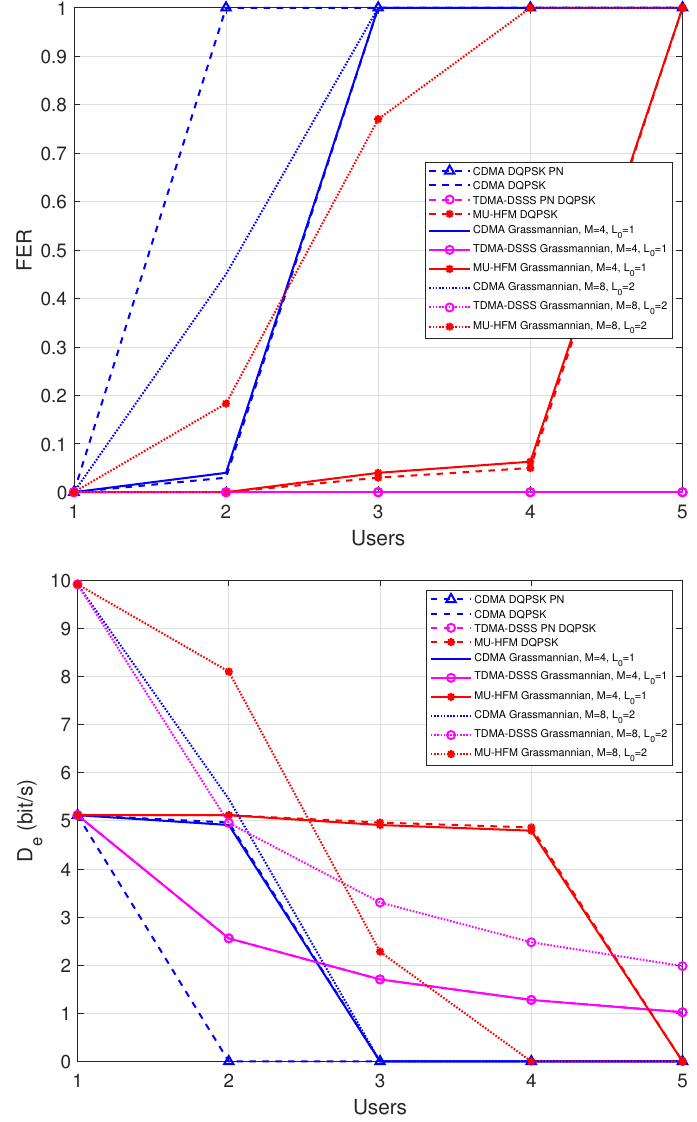
Figure 6. AverageFrame Error Rate (FER) performance ( up ) and effective data rate per user ( down ) versus the number of users for the replayed channel of the roadstead of Brest, where N r = 1 sensor, and average SNR = 10 dB. The abbreviation PN means that a PN code type preamble was used; in the other cases, a MU-HFM type preamble was